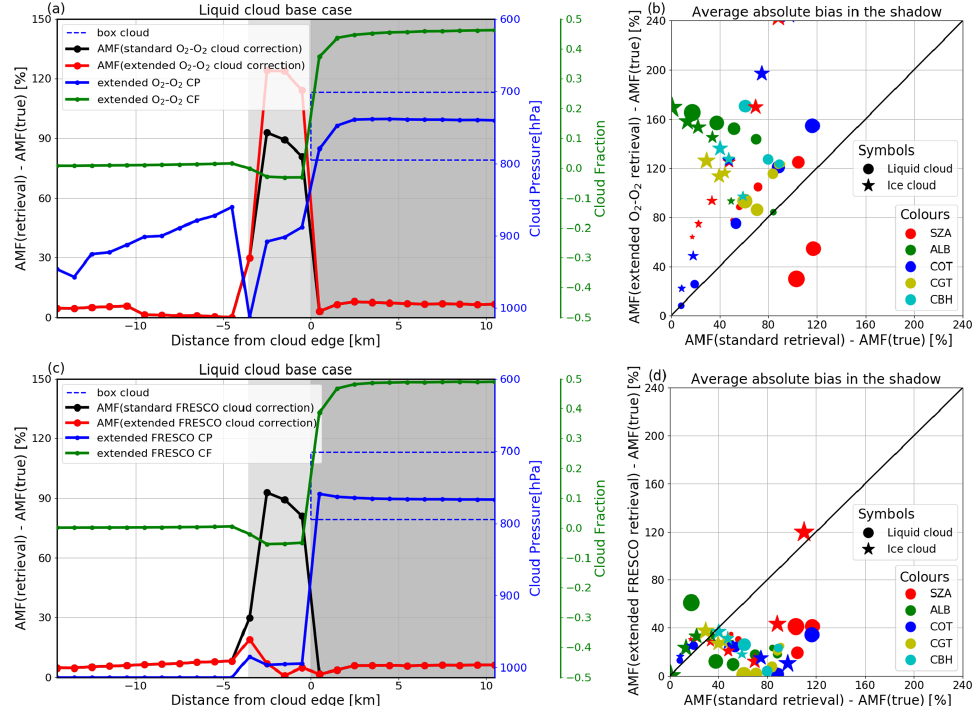
Figure 11. Examples of NO 2 AMF retrieval using the extended O 2 –O 2 (a, b) and FRESCO (c, d) cloud. (a, c) Comparison of the AMF biases based on the standard retrieval approach and the AMF calculated with the extended cloud retrievals for liquid cloud base case. The dark grey, light grey, and white regions represent cloudy, cloud shadow, and clear scenes, respectively. (b, d) Comparison of the AMF biases for the simulations with a box cloud. Each point represents the average bias in the cloud shadow, and colours correspond to various parameters for the cases with the liquid cloud (circles) and ice cloud (stars). The biases are shown in relative values, and the various marker sizes represent different parameter